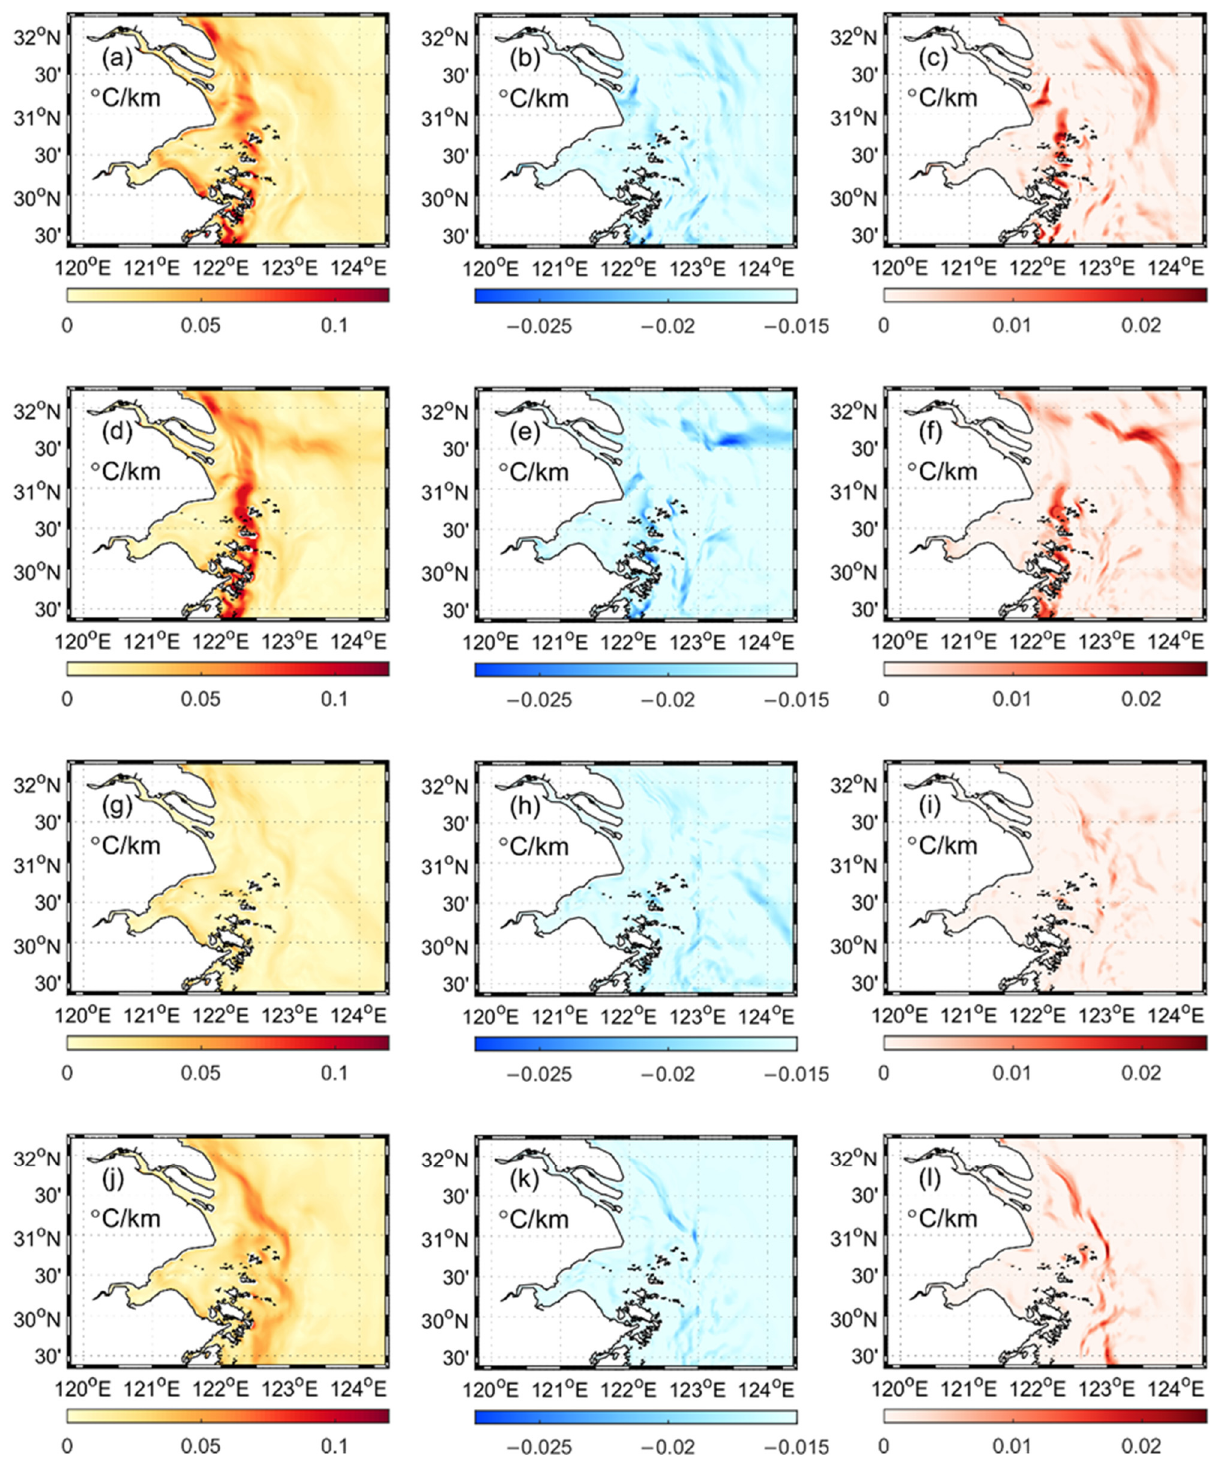
Figure 7. Influence of scarce or abundant situation of runoff on surface fronts. ( a , d , g , j ) (case 1 results in Spring, Summer, Autumn and Winter); ( b , e , h , k ) (the difference between case 1 and case 5 in Spring, Summer, Autumn and Winter); ( c , f , i , l ) (the difference between case 1 and case 4 in Spring, Summer, Autumn and Winter).